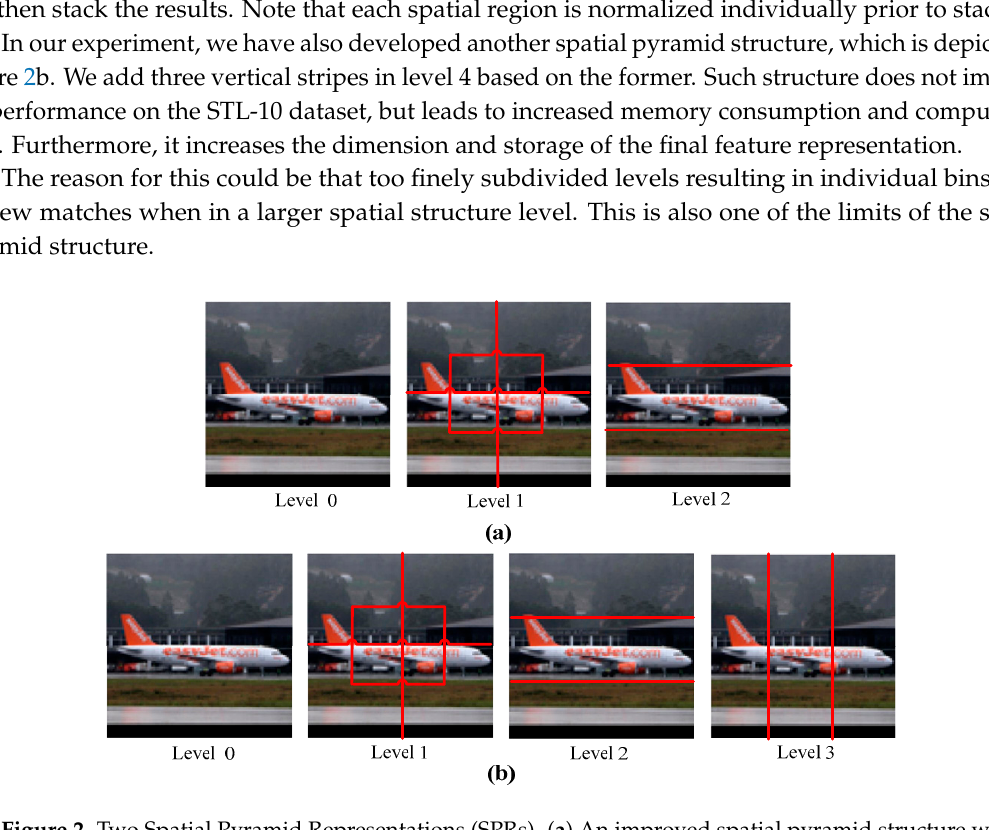
Figure 2. Two Spatial Pyramid Representations (SPRs). ( a ) An improved spatial pyramid